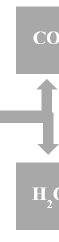
Scheme 1. Block diagram showing the possible paths for oxidizing CO–H 2 mixture.